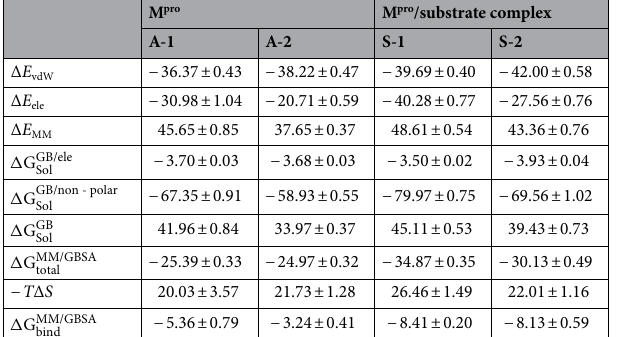
Table 2. MM/GBSA-calculated binding free energy and energy components (kcal/mol) for top two clusters of rubraxanthone binding to free enzyme and enzyme–substrate complex allosteric